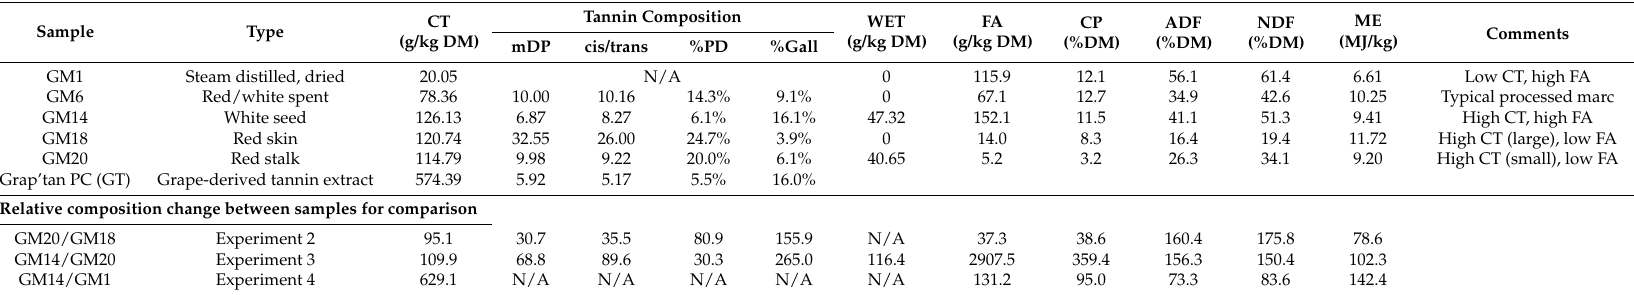
Table 1. Key compositional information for selected grape marc samples (upper panel), as determined by Hixson et al. (2016) [12], and relative compositional change between grape marc samples being compared in this work (lower